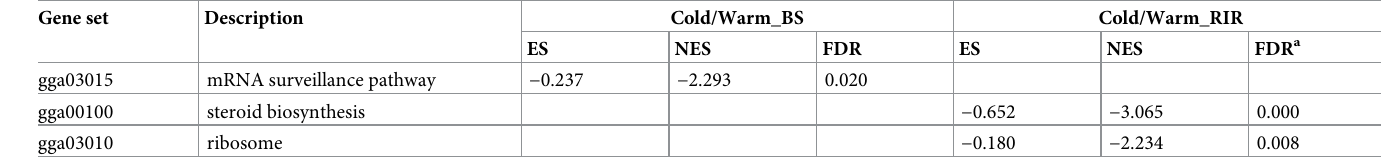
Table 8. GSEA tests for KEGG pathway enrichments for gene expression plasticity in BS and RIR chicken